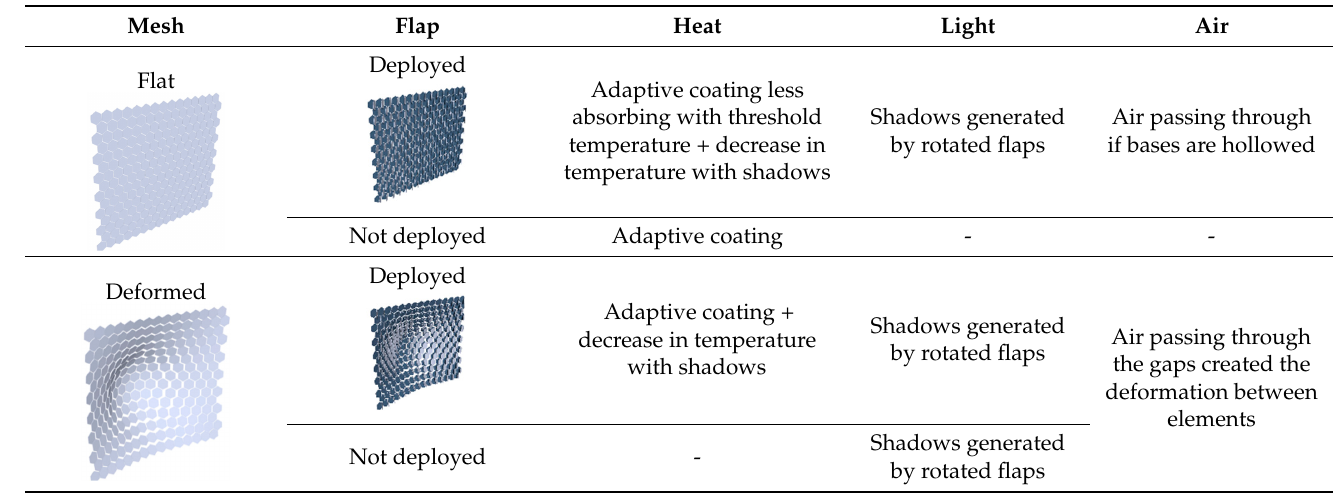
Table 2. Managed functions according to configurations. For visual display, flaps are white and base elements are dark grey.